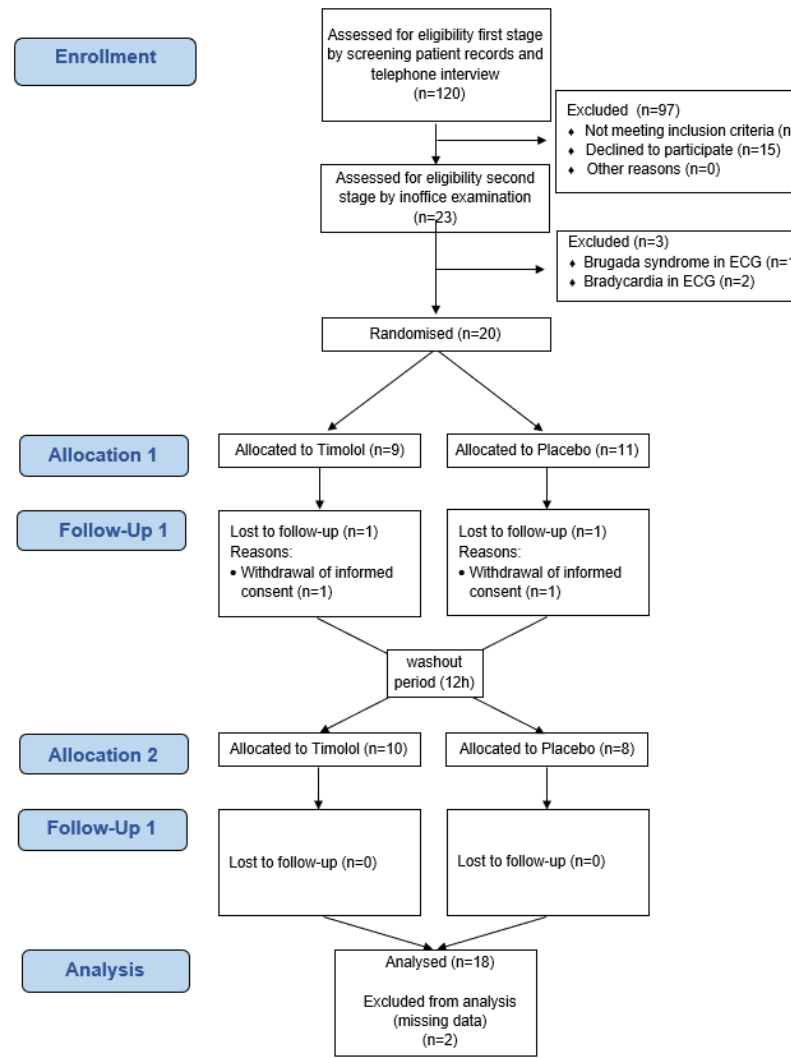
Figure 2. Flow Diagram of patients of the TIM-HHT study.